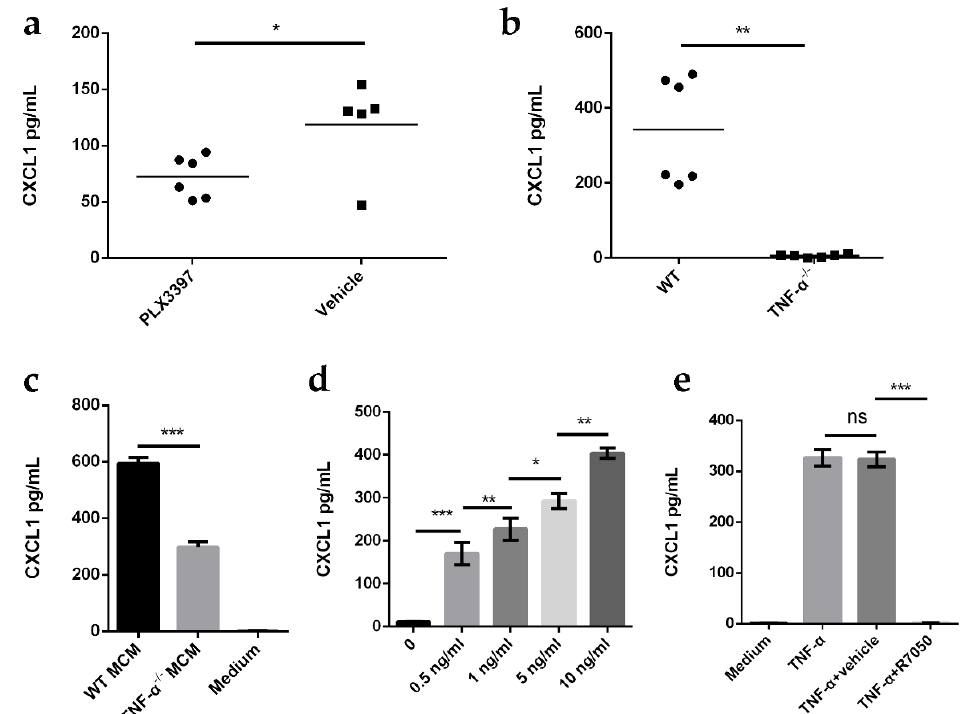
Figure 6. TNF- α produced from microglia promotes CXCL1 release by astrocytes. ( a ) Mice were pretreated with PLX3397 or vehicle (negative control) for 2 weeks, and then infected with E. coli K1 for 12 h. CXCL1 protein levels in the mouse brain were analyzed by ELISA ( n = 5 mice for vehicle; n = 6 mice for PLX3397). ( b ) ELISA analysis of CXCL1 protein levels in the brains of wild-type (WT) mice and TNF- α -deficient mice infected with E. coli K1 for 12 h ( n = 6 mice per group). ( c ) ELISA analysis of CXCL1 protein levels in astrocytes cultured with wild-type (WT) or TNF- α − / − microglia- conditioned medium (MCM) for 2 h. ( d ) ELISA analysis of CXCL1 protein levels in astrocytes treated with different concentrations of TNF- α . ( e ) Primary astrocytes were pretreated with TNF- α receptor antagonist R-7050 or vehicle (negative control) for 1 h and then treated with TNF- α for 2 h. CXCL1 protein levels in astrocytes were analyzed by ELISA. Data are presented as mean ± SD, n = 3 independent experiments ( c – e ). p values were determined using Mann–Whitney U test ( a , b ) or Student’s t -test ( c – e ). * p < 0.05; ** p < 0.01; *** p < 0.001; ns, not